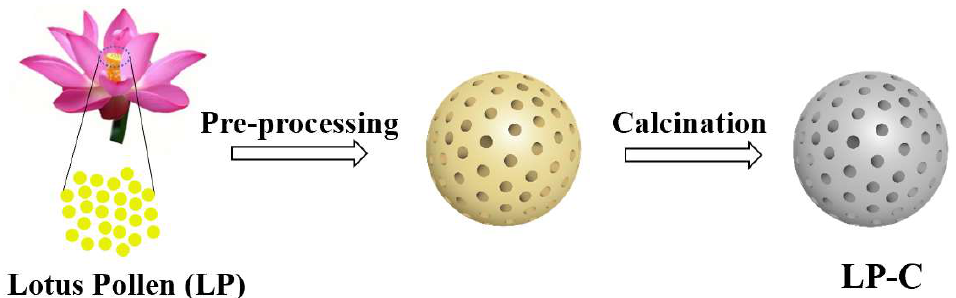
Figure 1. Schematic diagram of the synthetic route of pollen carbon materials.